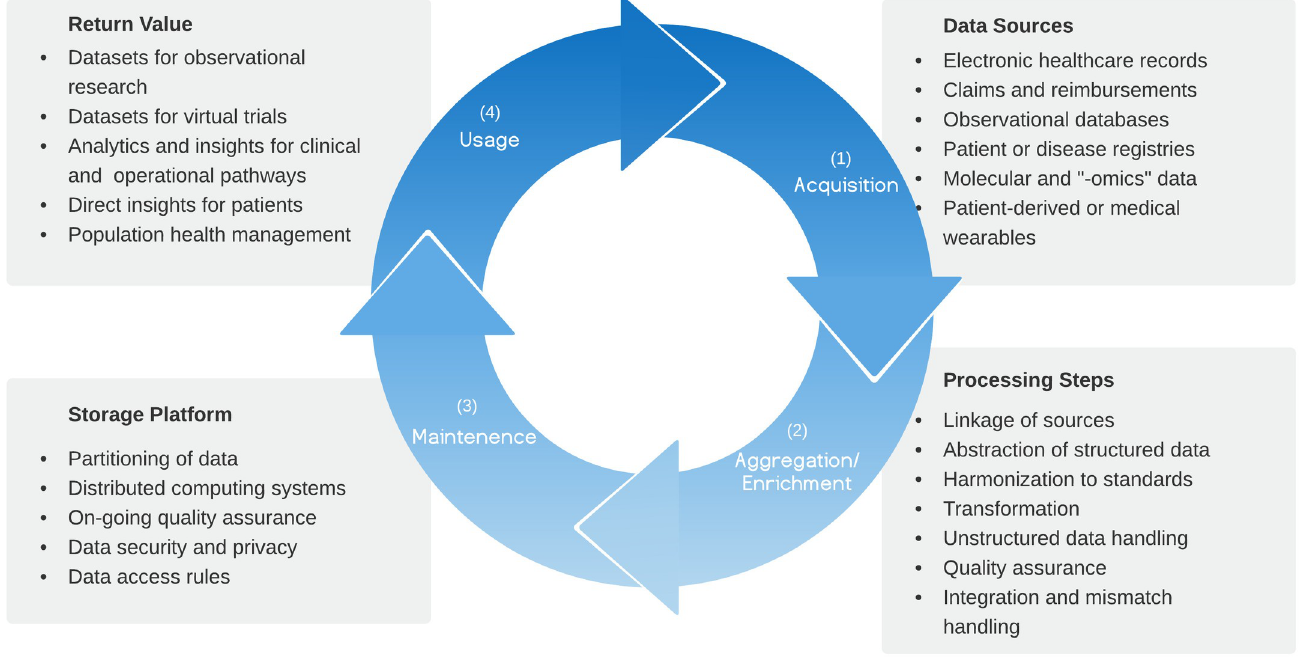
Fig 1. The illustrated life cycle is a series of necessary or recommended steps that produce RWD usable for analysis, from raw data generated by clinical encounters or operational workflows. Insights gained from data use can be returned to the life cycle, enriching future generation of clinical data. RWD AU : AbbreviationlistshavebeencompiledforthoseusedinFigs 1 and 2 : Pleaseverifythatallentriesarecorrect : , real-world